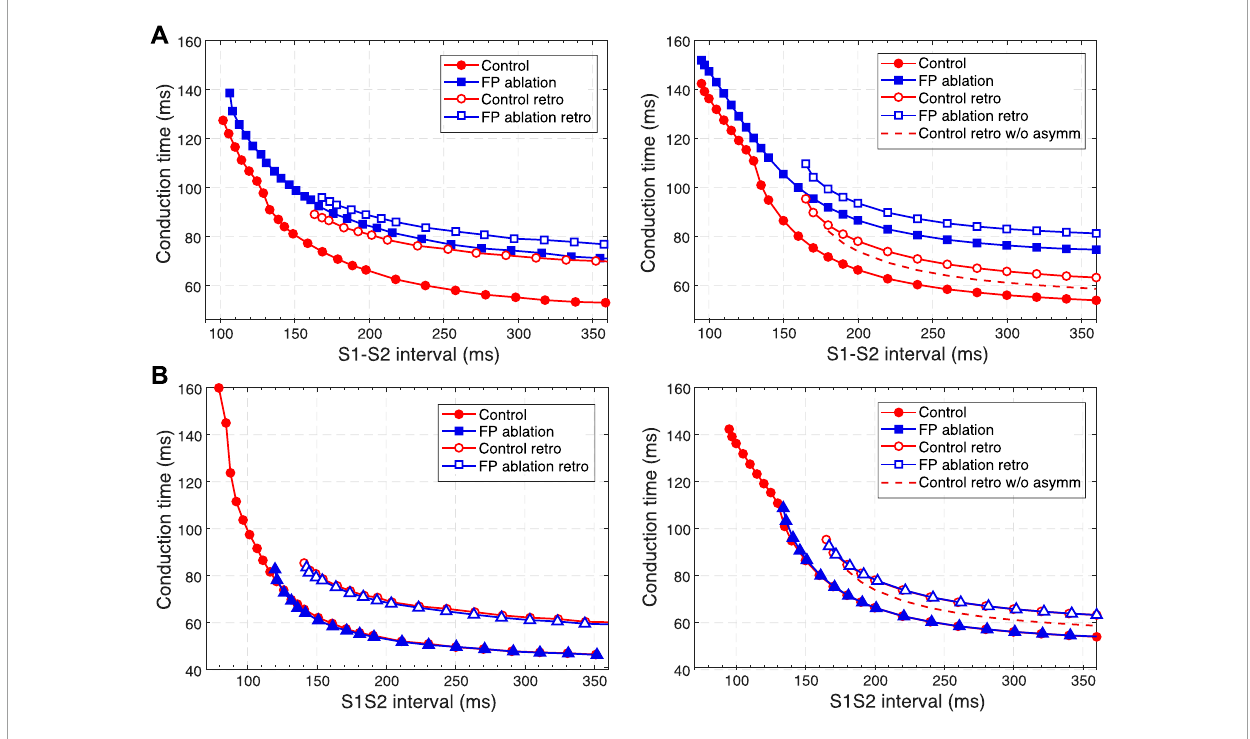
FIGURE 9 Comparison of experimental (Reid et al., 2003) (left panels) and simulated (right panels) anterograde and retrograde recovery curves in the control case and after FP and SP ablations. (A) Experimental recovery curves in the control case and after FP ablation and simulated recovery curves. (B) Experimental recovery curves in the control case and after SP ablation and simulated recovery curves. Dashed lines correspond to the simulated retrograde conduction in the control case without coupling